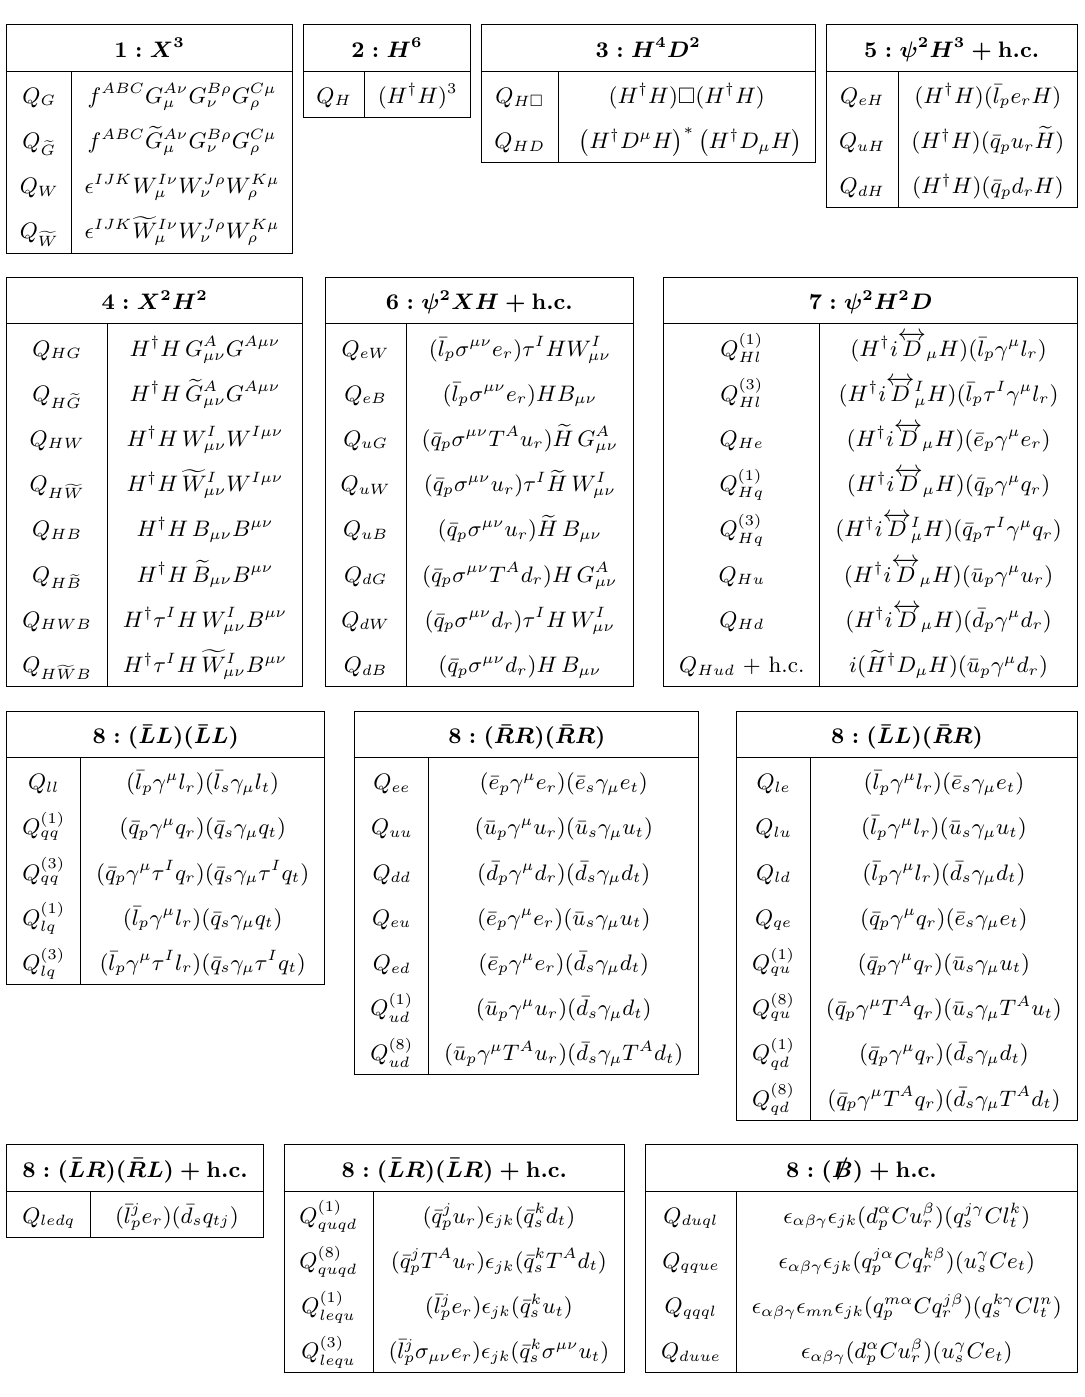
Table 21 . The dimension-six operators in the SMEFT. The operators are divided into eight classes according to their (cid:12)eld content. The class-8 4 four-fermion operators are further divided into subclasses according to their chiral and baryonic properties. Operators with + h : c : have Hermitian conjugates, as does the 2 H 2 D operator Q Hud . The subscripts p; r; s; t are weak-eigenstate indices.